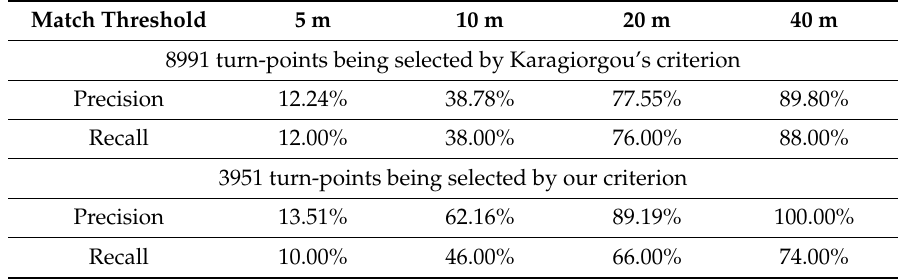
Table 4. Detection precision and recall using the Chicago dataset.